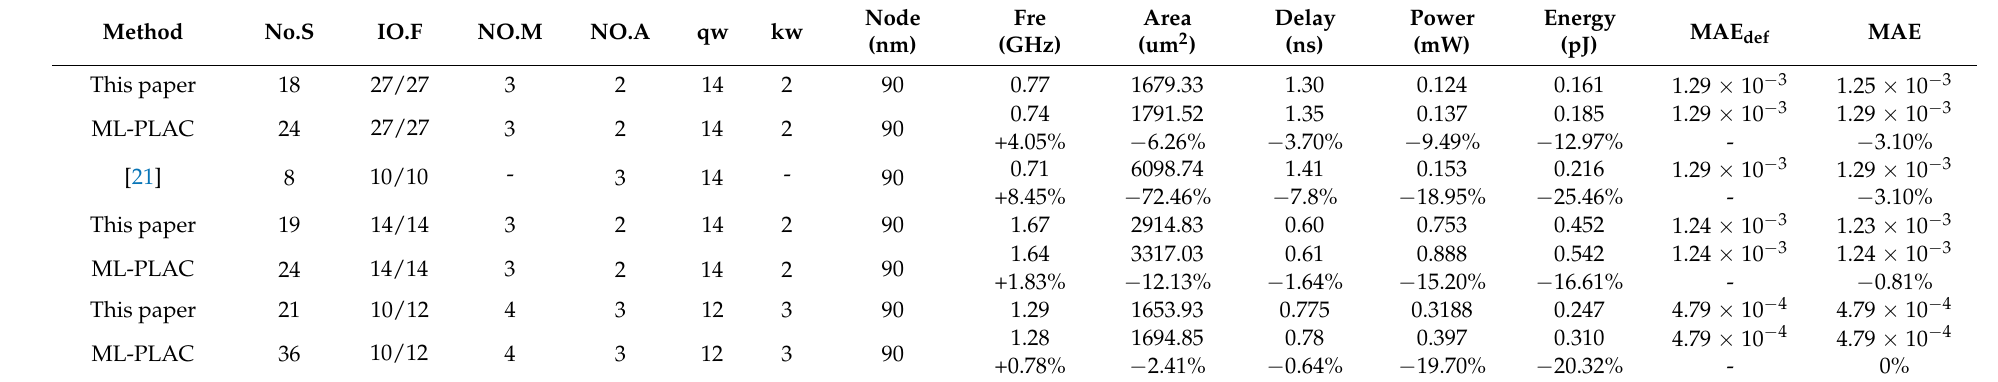
Table 6. Performance comparison for 2 x , x ∈ [ 0,1 )